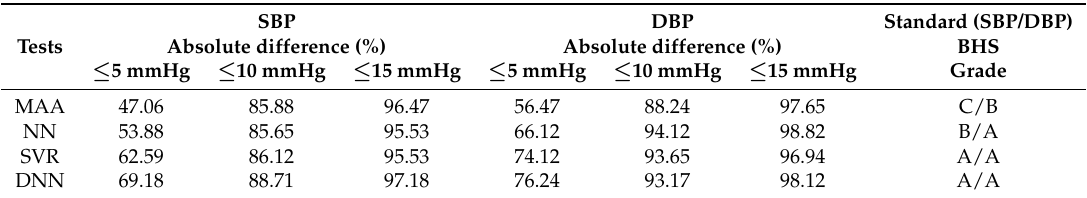
Table 6. Grading of the proposed algorithm based on the BHS standard using the results of MAA, NN, SVR, and DNN on (5 × 85 = 425)